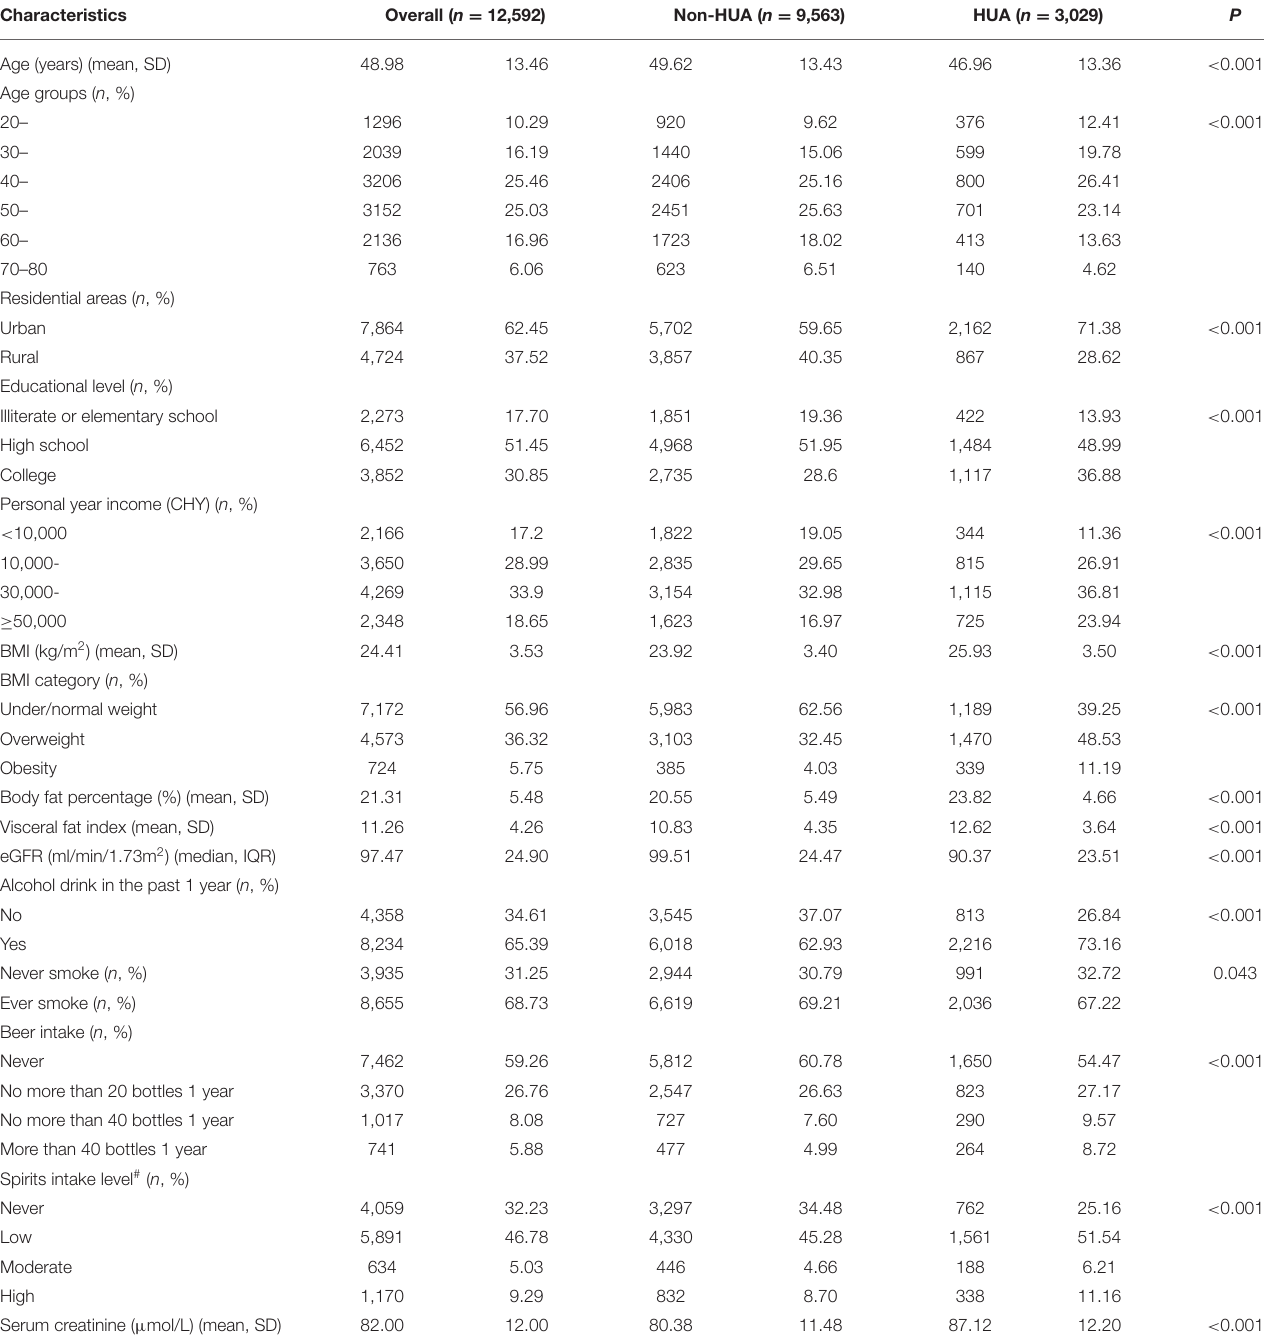
TABLE 1 | Sociodemographic and health characteristics of male participants in mainland China.